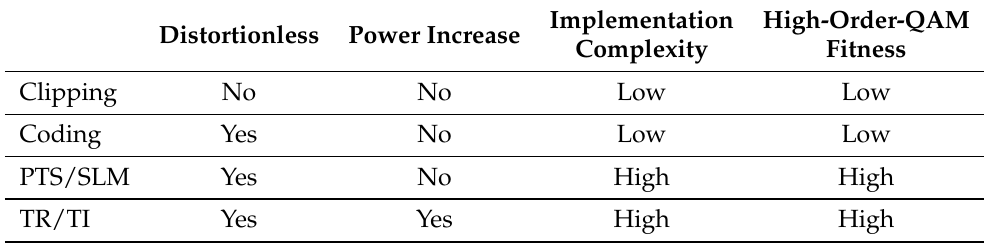
Table 1. List of PAPR reduction schemes comparisons.